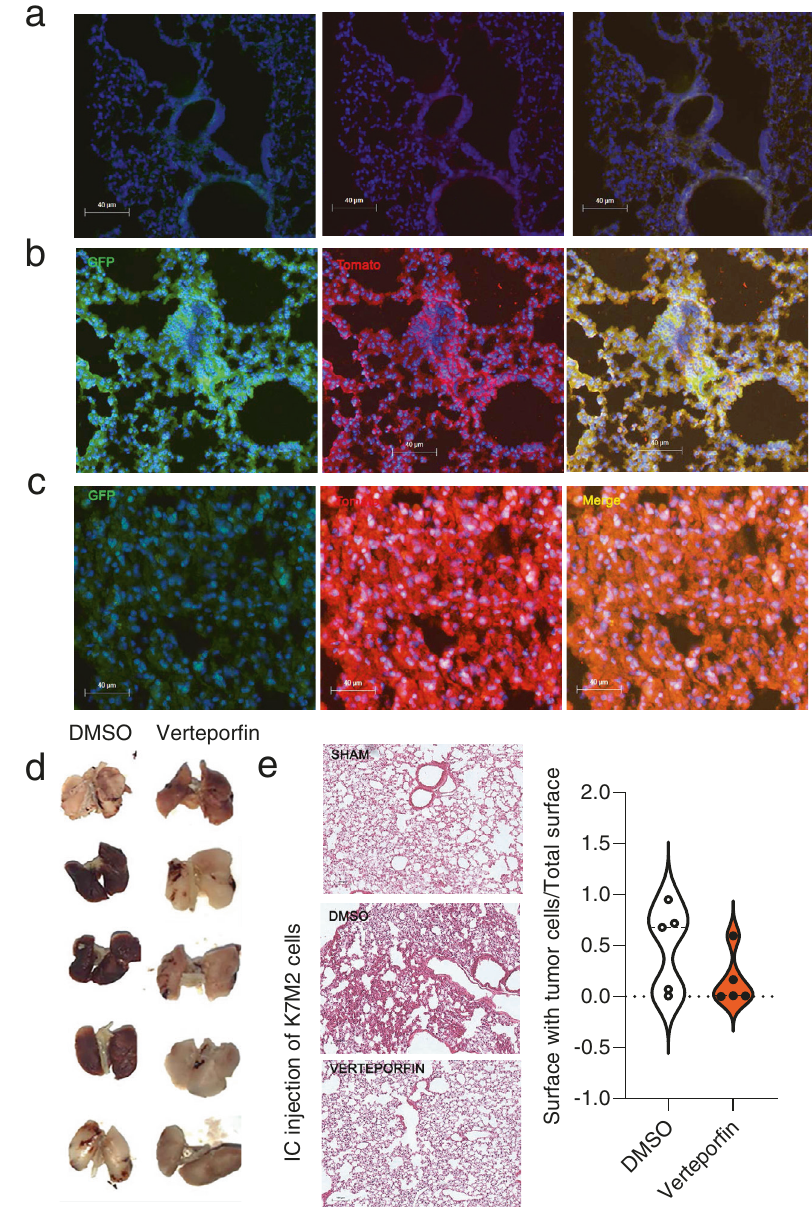
Fig. 7 Calpain-6/YAP axis is involved in metastasis out-growth. a – c Detection of tumor cells in lungs after intracardiac injection of PBS ( a ) or K7M2 cells ( b , c ). Lungs of injected mice were collected and paraf fi n-imbedded 11 days or 5 weeks after cell injection. Tomato (red) and GFP (green) immuno fl uorescence shows tumor and Calp6-P-GFP + cells, respectively. d Photos of lungs 34 days after intracardiac (IC) injection. Mice were treated with DMSO or vertepor fi n as indicated. e Representative photos of lung sections from DMSO- vs vertepor fi n-treated mice 5 weeks after IC injection of K7M2 cells (H&E staining) and quanti fi cation of the surfaces of lungs with tumor cells.